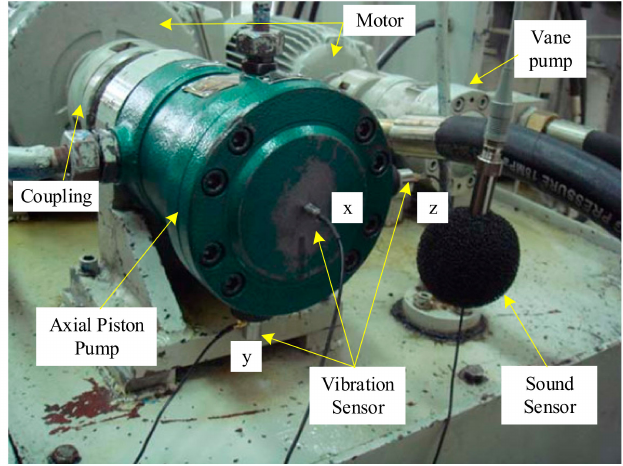
Figure 2. Installation of an experimental